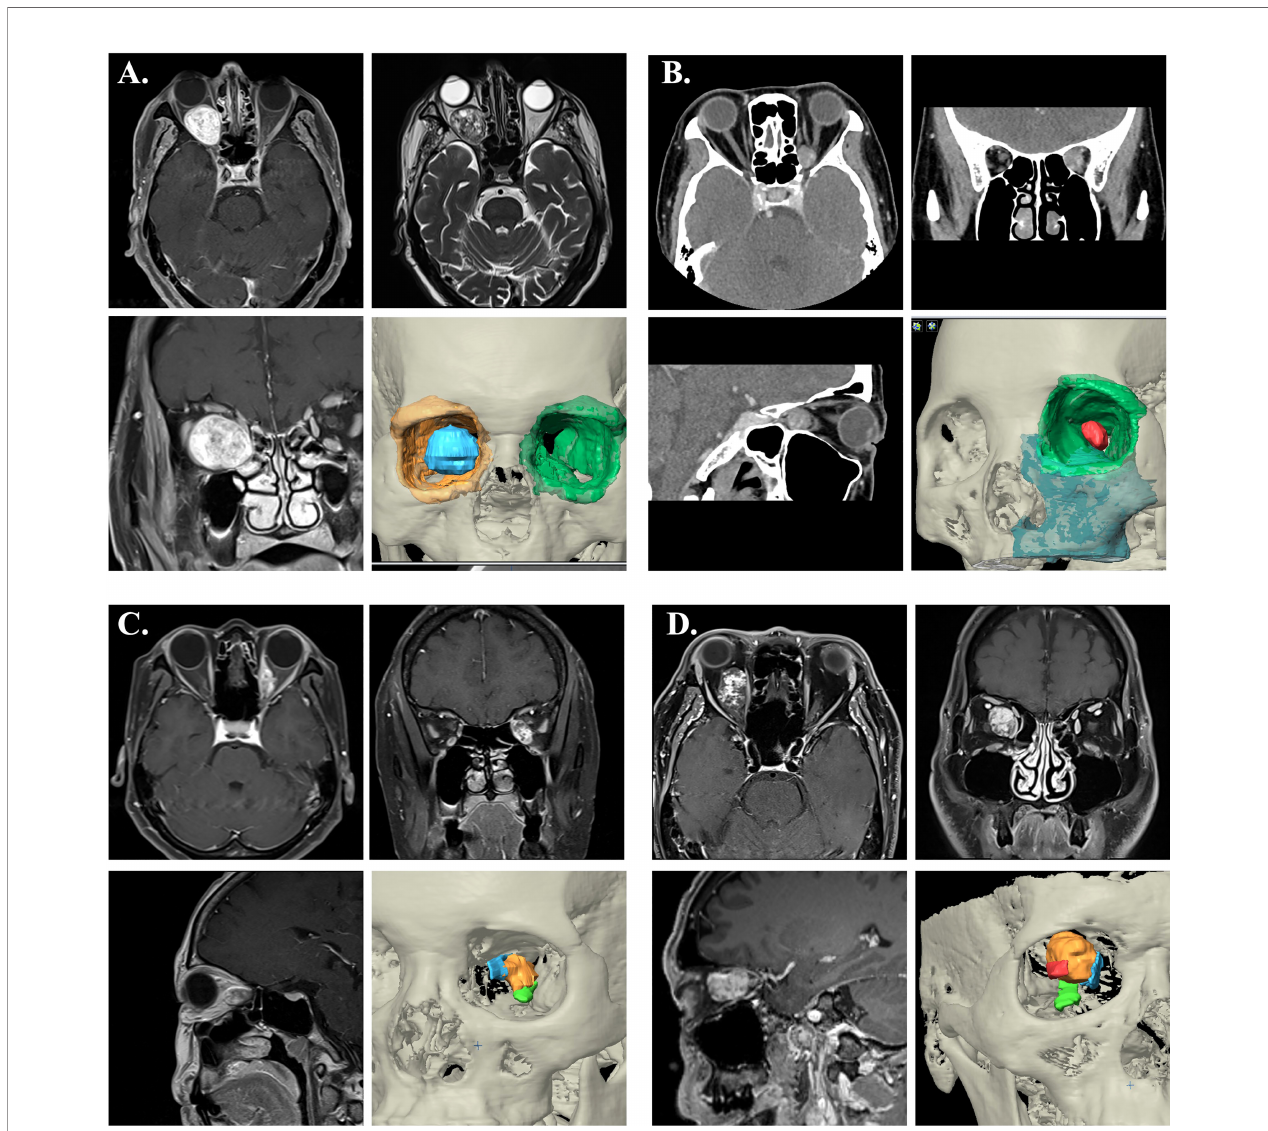
right optic nerve upward and causing right proptosis. 3D image rendering tumor lesion was demonstrated (blue). (B) The CT showed an ovoid, well-de fi ned with contrast-enhanced mass at the medioposterior extraconal space and medial to the apical region of the optic nerve. 3D image rendering tumor lesion was demonstrated (red). (C) The MRI demonstrated an enhancing mass at medial side of left intraconal space (orange), which involving the medial rectus muscle (blue) and superior to inferior rectus muscle (green). (D) The MRI revealed a heterogeneously enhancing mass lesion at the right intraconal space (orange), medial to the optic nerve (red) that displaced laterally. (Blue: medial rectus muscle; Green: inferior rectus